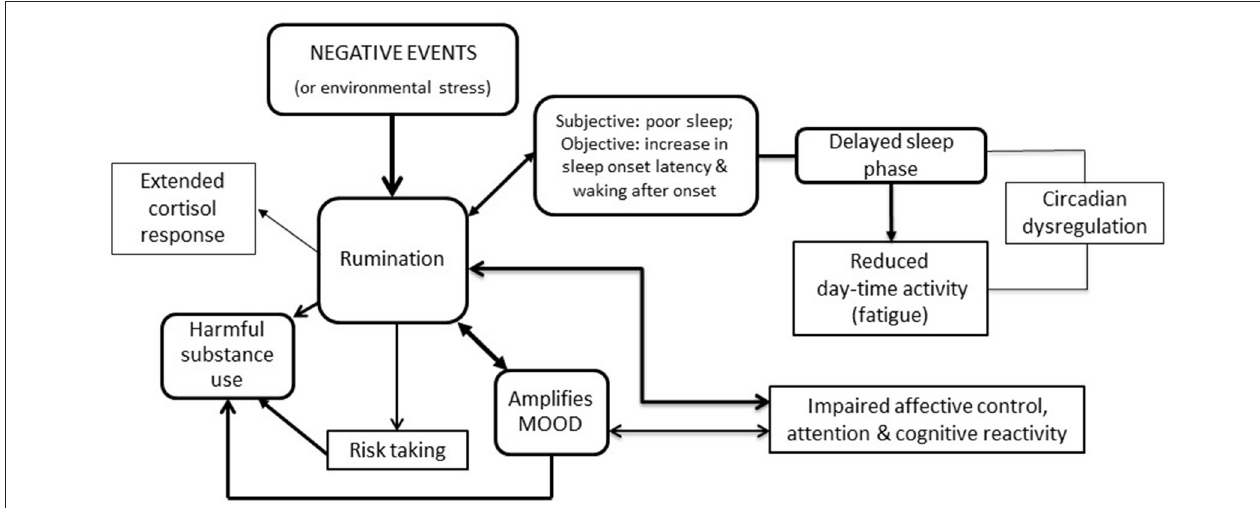
FIGURE 1 | Hypothesized links between rumination, risk taking, mood, substance use, sleep and activity (each link has been demonstrated empirically, but this working model is the first to draw connections between all the different elements).